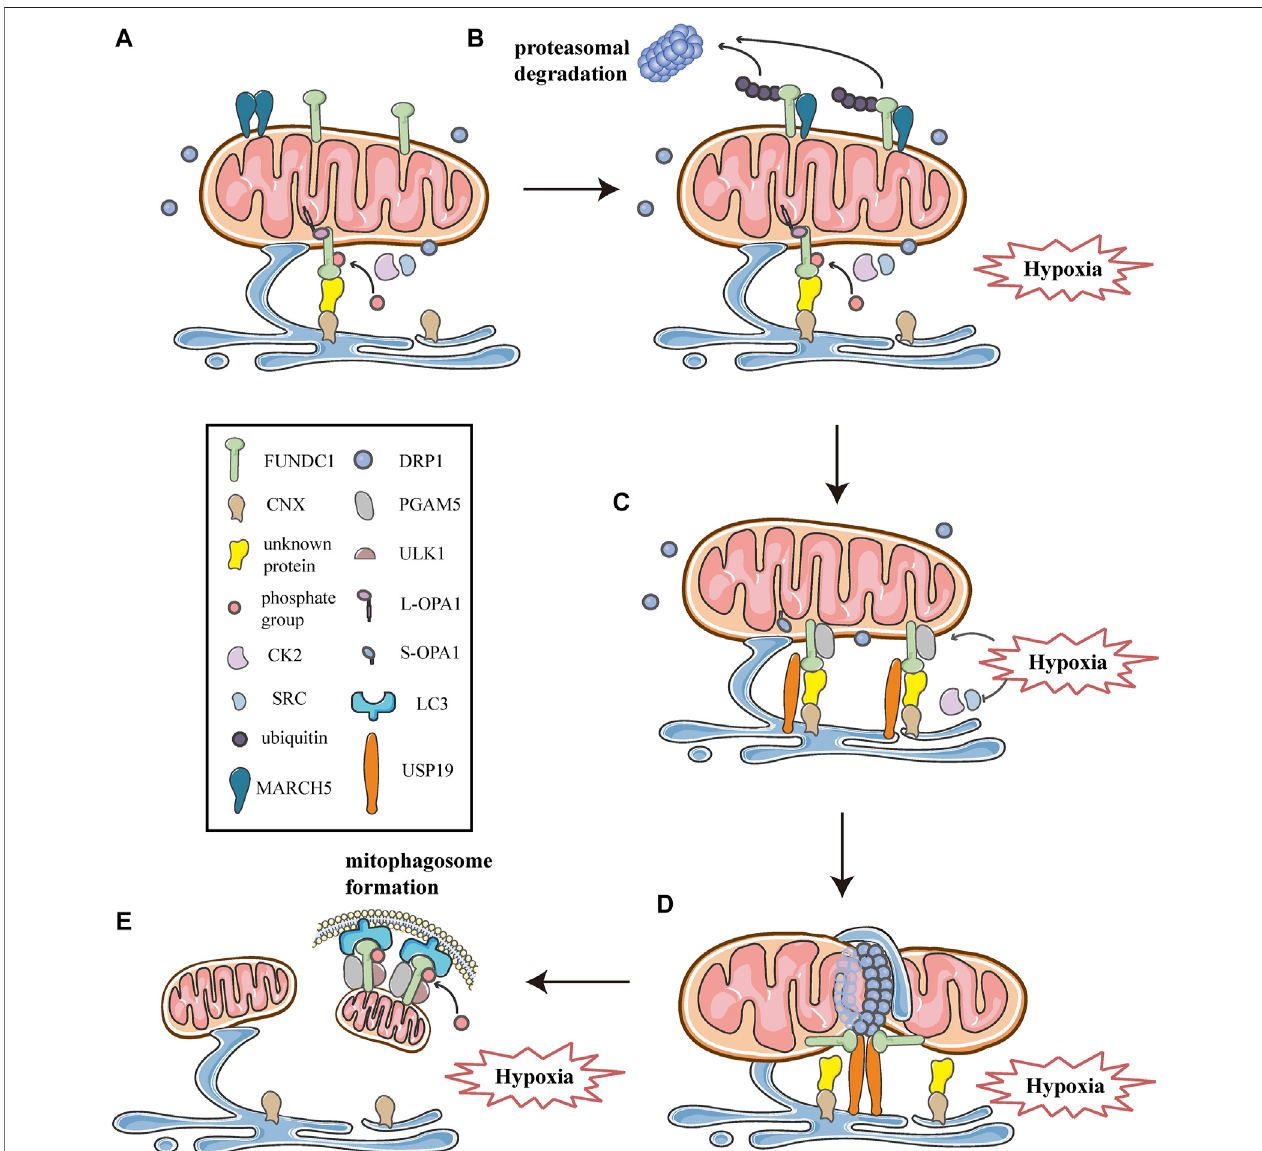
FIGURE7| Schematicdiagramsofthemolecularmechanismofmitochondrialdynamics,mitophagy,andMERCSscrosstalkunderhypoxia.FUNDC1actsasakeypointin themolecular machinery thatregulatestheclose link between mitochondrialdynamics and mitophagy at MERCSs under hypoxia. (A) FUNDC1 is an outer membrane protein of mitochondria. Under normal conditions, only a small amount of FUNDC1 is located on MERCSs, phosphorylated by CK2 or SRC kinase, interacting with OPA1 and indirectly bindingtoCNXviaanunknownprotein.MARCH5isamitochondrialE3ubiquitinligasethatlocalizesontheOMM,usuallyformingdimersoroligomers. (B) Attheinitialstage ofhypoxia,theoligomerofMARCH5disassembles,anditdirectlybindstoFUNDC1,mediatingtheubiquitin-proteasomeproteolyticpathwaythatdegradesFUNDC1.Meanwhile, theinhibitoryphosphorylationbySRCandCK2kinasesuppressestheactivityofFUNDC1,bothofwhichhinderFUNDC1-mediatedmitochondrial fi ssionandmitophagy,thereby avoidinginappropriateclearanceofundamagedmitochondria. (C) Ashypoxiaprogresses,activitiesofSRCandCK2kinaseareinhibited,whilePGAM5phosphataseisactivated, leading to dephosphorylation of FUNDC1 dissociated from OPA1. Moreover, USP19 signi fi cantly accumulates at MERCSs and strongly binds to FUNDC1, which is deubiquitinated and stabilized at MERCSs, where FUNDC1 indirectly interacts with CNX. The FUNDC1-CNX association contributes to the formation of a close connection betweentheERandmitochondria. (D) Subsequently,FUNDC1dissociatesfromCNXwhileinteractingwithDRP1,andUSP19-mediated FUNDC1stabilizationpromotesDRP1 oligomerizationatMERCSs,leadingtohypoxia-inducedmitochondrial fi ssion. (E) Atthelatestageofhypoxia,FUNDC1bindstoLC3andformsanmitophagosome,whichengulfs and selectively removes impaired mitochondria. Meanwhile, the upstream ULK1 complex phosphorylates FUNDC1 to promote the process of mitophagy.